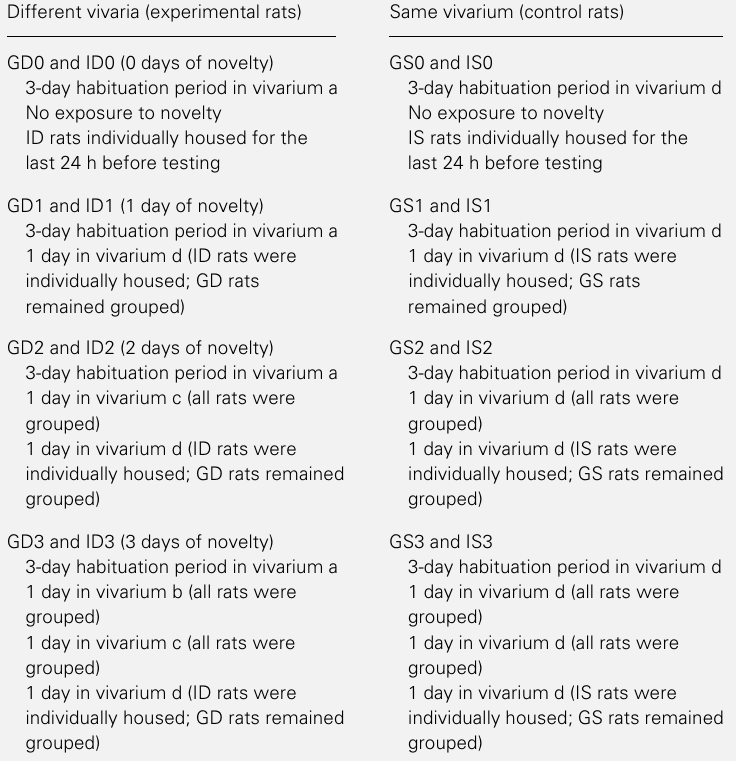
Table 1 - Protocol of exposure to novelty for control and experimental